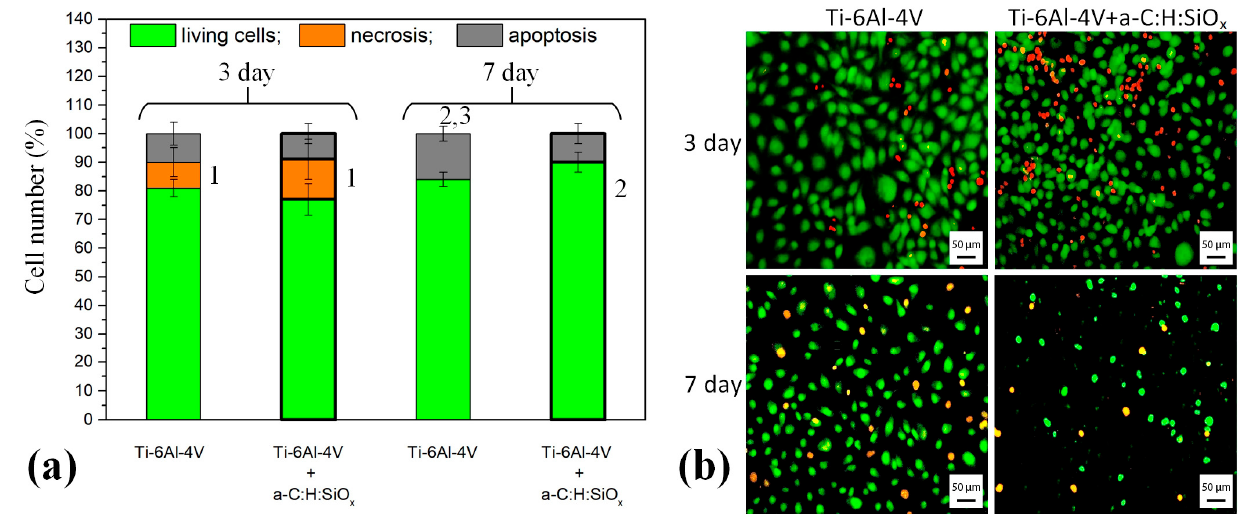
Figure 9. Block diagram ( a ) of EA.hy926 cell death on Ti substrates: 1—necrotic cells vs. those after 7 days ( p = 0.01), 2—live cells vs. those on T1–T2 substrates after 3 days ( p < 0.05), 3—live cells vs. those on T2 substrate after 7 days ( p = 0.04). Data are presented as mean ± SD. Six measurements were performed in each group. Cell distribution maps ( b ) on T1 and T2 substrates. Staining: acridine orange and ethidium bromide. Scale bar: 50 µ m. Magnification: 200 ×